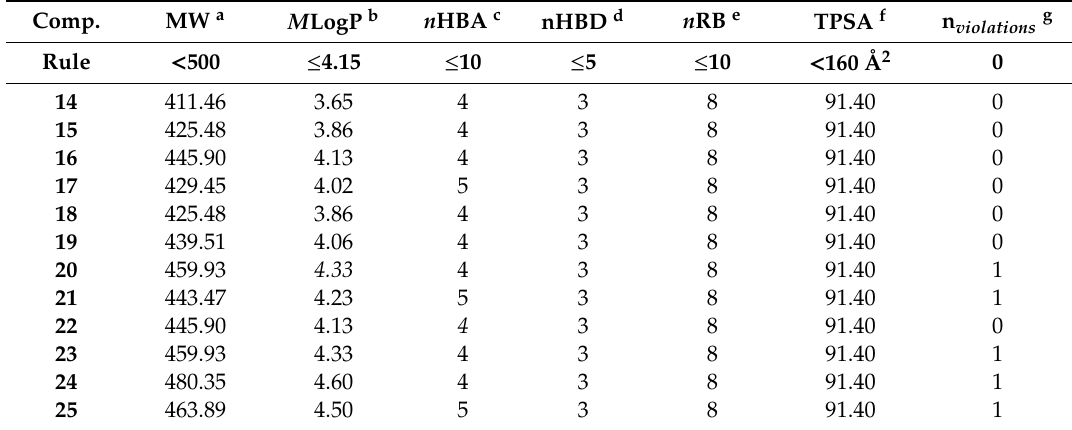
Table 3. In silico prediction of Lipinski‘s rule of five for the Schi ff bases 14 – 25 . Comp.